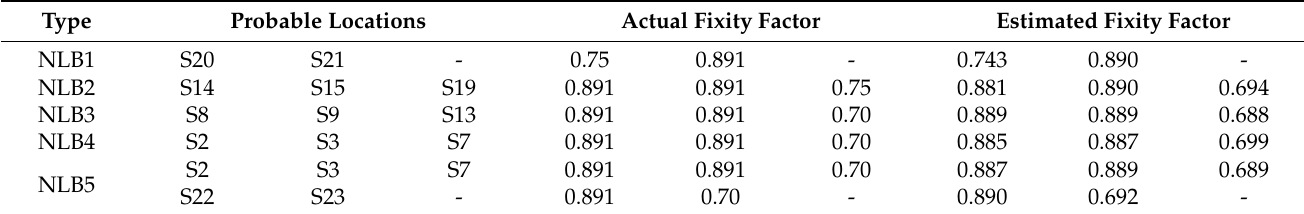
Table 11. Estimated fixity factors for four storey numerical